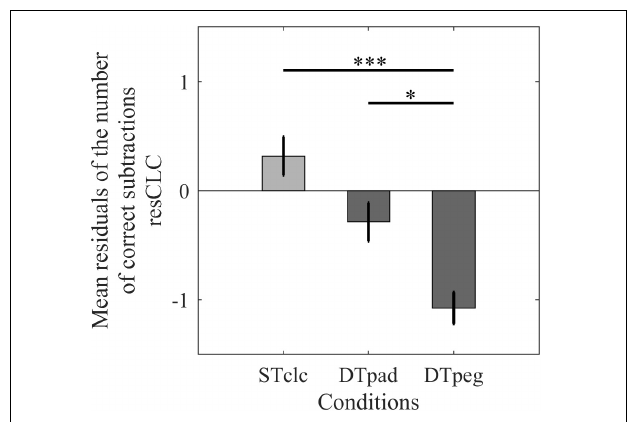
FIGURE 4 | Cognitive performance as mean relative number of correct calculations (resCLC) for single-task calculation (STclc) and for the two dual-task conditions (Paddleball: DTpad; Pegboard: DTpeg). Error bars represent standard errors of the mean. ∗ p < 0.05, ∗∗∗ p < 0.001.